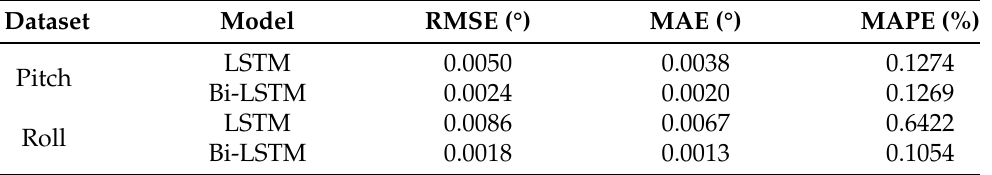
Table 2. Error comparison of USV attitude angle prediction.